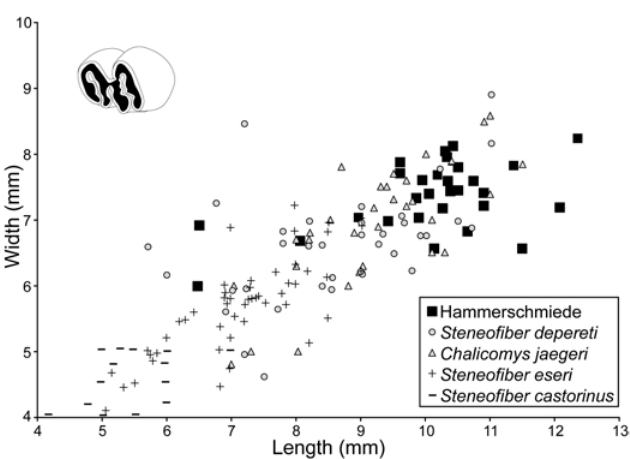
Fig. 8. Length/width dimensions of lower premolars of the beaver Steneo- fiber depereti Mayet, 1908, from the early Late Miocene locality Hammer- schmiede (Bavaria, Germany), local stratigraphic levels HAM 5 and HAM 4, compared to S. depereti and several other castorid species from other European Miocene localities. Data for non Hammerschmiede S. de- pereti from Mörs and Stefen (2010) and citations therein, for Chalicomys jaegeri from Stefen (2009) and citations therein, for Steneofiber eseri from Stefen (1997), and for Steneofiber castorinus from Filhol (1879). Data points for all taxa resemble both occlusal and basal tooth